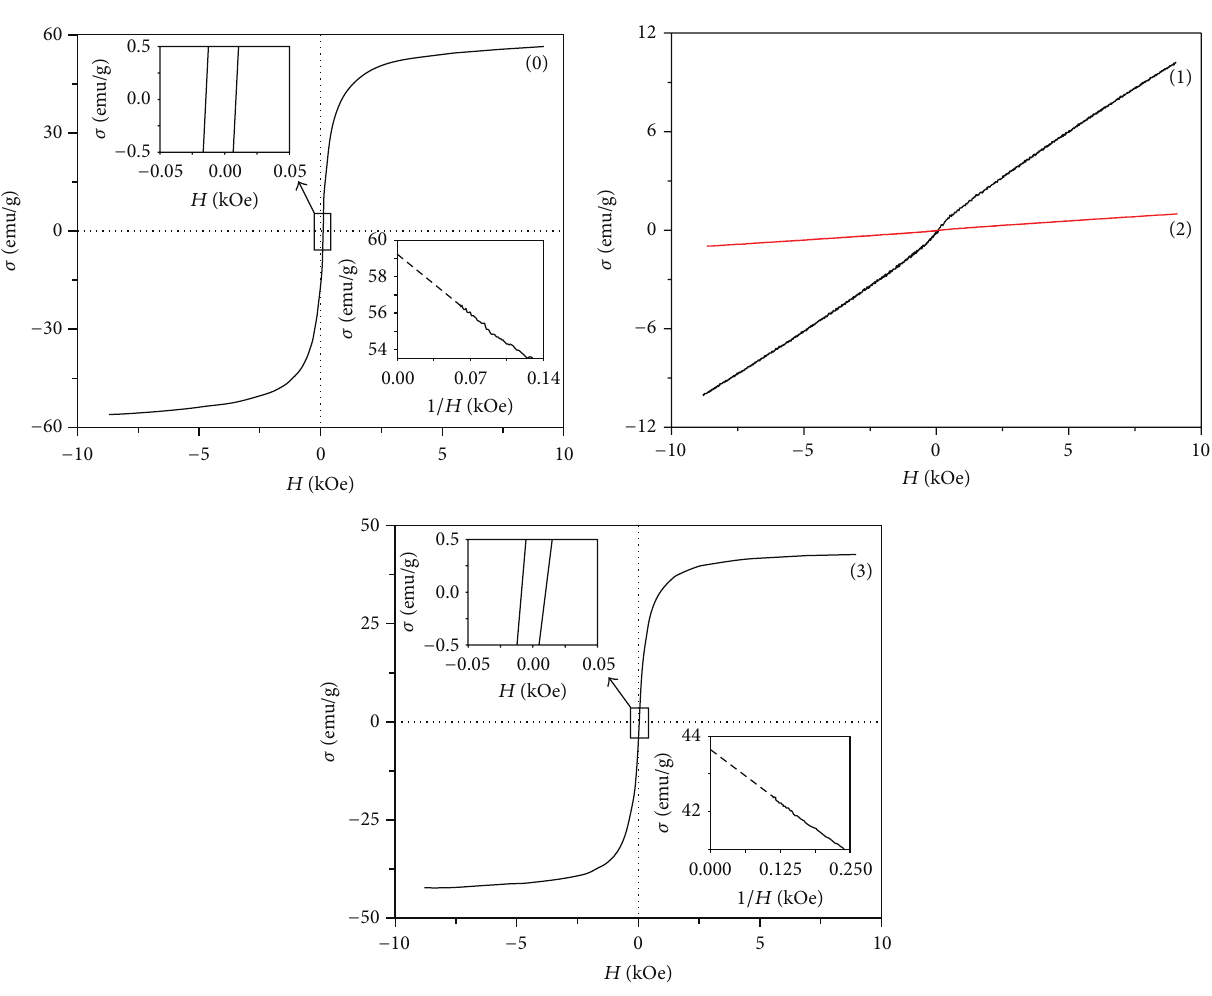
Figure 2: Specific magnetization curves measured at room temperature for all samples.